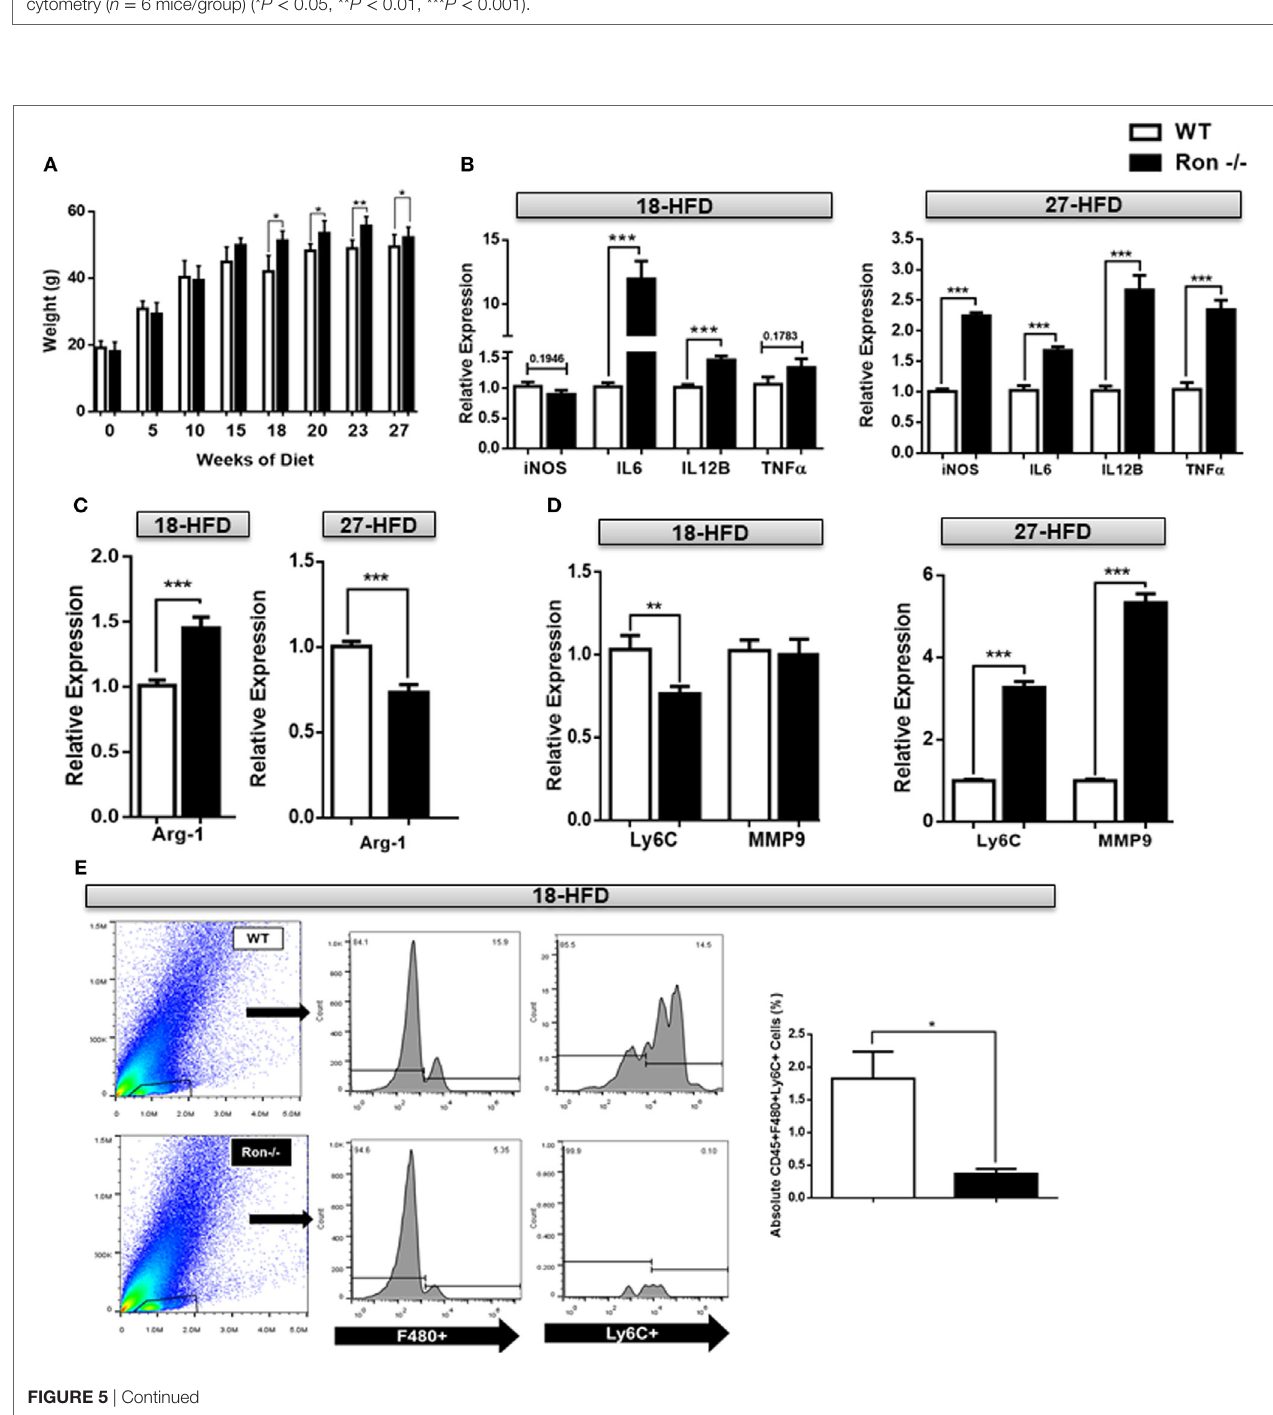
FigUre 4 | High fat diet-induced obesity promotes inflammation in the central nervous system (CNS). (a) Weight of mice following 18 weeks on a HFD or chow controls ( n = 18 mice/group). (B) A terminal intra-peritoneal glucose tolerance test was performed on mice following 18 weeks on a HFD or chow controls ( n = 6 mice/group). (c) Representative body morphology of mice following 18 weeks on a HFD or chow controls. (D) Circulating leukocyte counts from mice following 18 weeks on a HFD or chow controls ( n = 10–12 mice/group). (e–g) Mice were maintained on a HFD or chow for 18 weeks and expression of M1-associated genes, M2-associated genes and matrix metalloproteinases (MMPs) in the CNS was assessed by qPCR ( n = 12 mice/group). (h,i) Total CNS immune cells were isolated from mice maintained on a HFD or chow for 18 weeks and the number of CD45 + F4/80 + Ly6C + infiltrating monocyte/macrophages was assessed by flow cytometry (